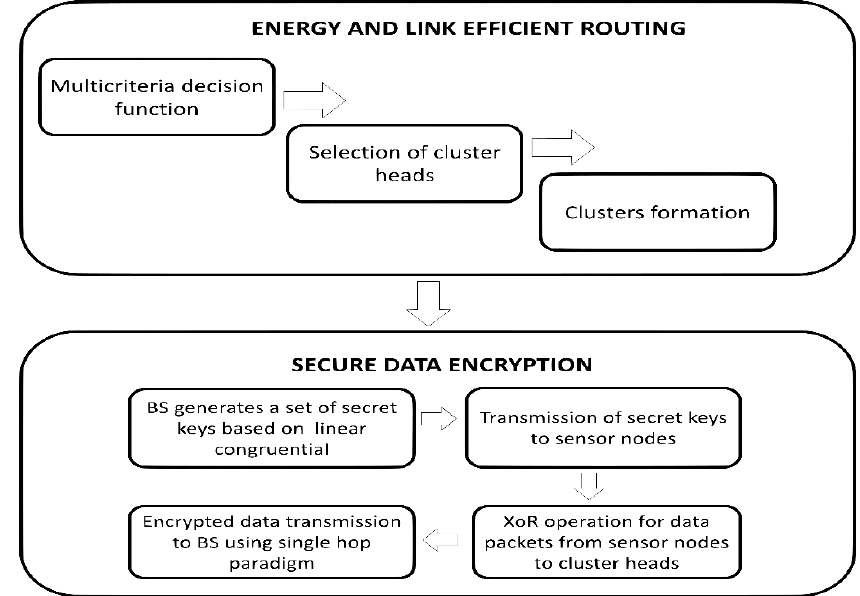
Figure 2. The research design of proposed energy-efficient and secure IoT-based WSN framework for smart agriculture.